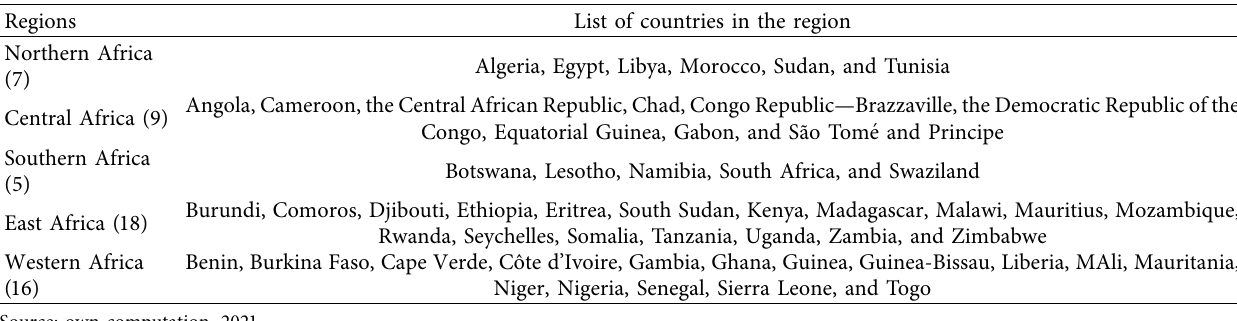
Table 1: African regions with their respective numbers and a list of countries. Regions List of countries in the